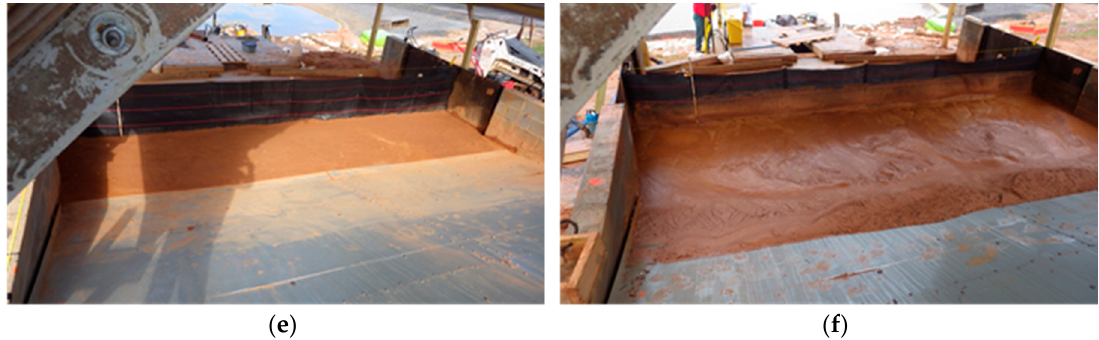
Figure 4. Pre- and post-test documentation illustrating sediment capture, ( a ) ALDOT Trenched Silt Fence prior to testing, ( b ) ALDOT Trenched Silt Fence test area after P-3, ( c ) ALDOT Sliced Silt Fence prior to testing, ( d ) ALDOT Sliced Silt Fence test area after P-1, ( e ) AL-SWCC Trenched Silt Fence prior to testing, ( f ) AL-SWCC Trenched Silt Fence test area after P-3.